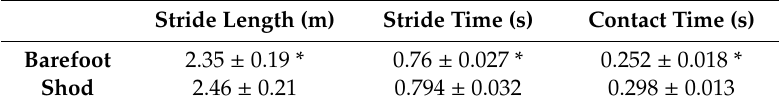
Table 1. The spatiotemporal parameters between barefoot and shod running.